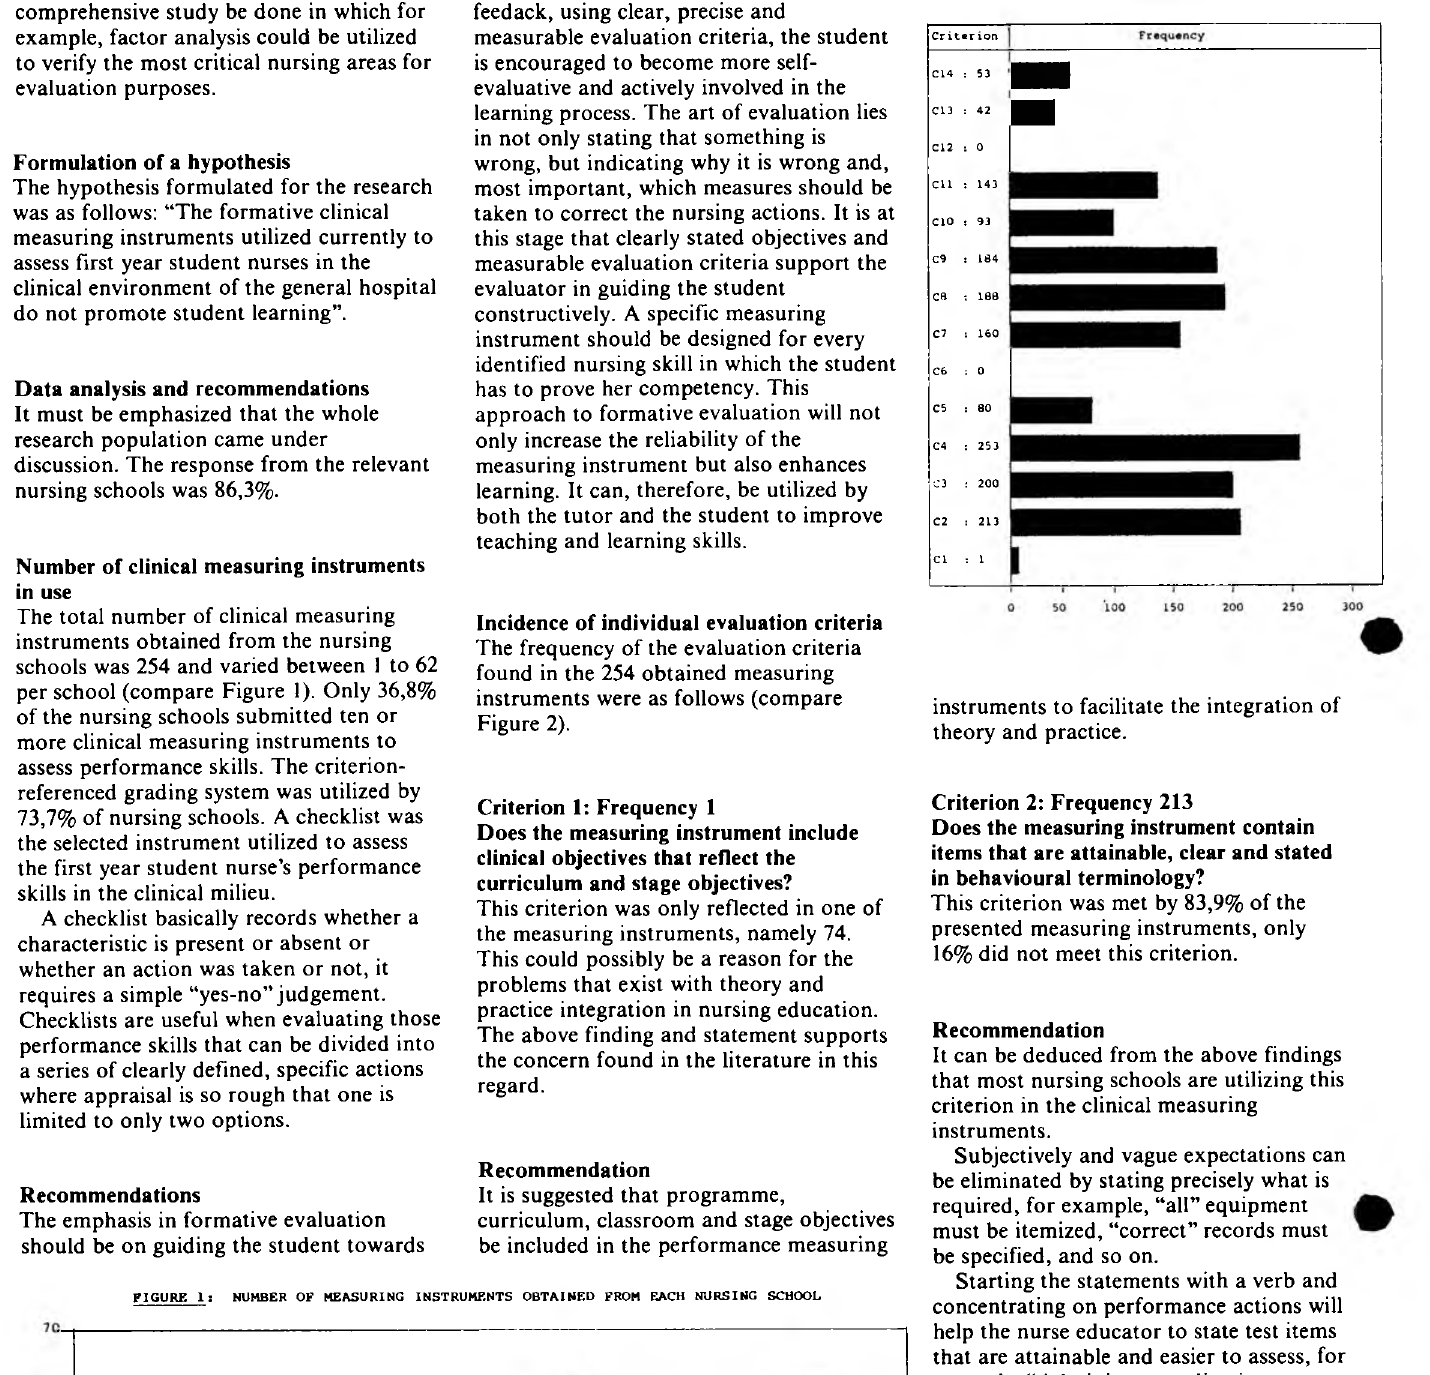
FIGURE 2: FREQUENCY OP USE OP EVALUATION